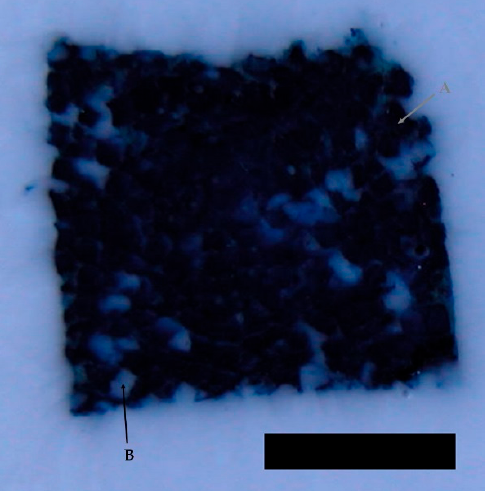
Figure 3. Illustration of pore interconnectivity in a hyaluronic acid gelatin composite scaffold. Black areas represent accessible pores whereas white areas signify secluded pores. Arrow A points to an interconnected, accessible pore. Arrow B points to a non-interconnected, secluded pore. Most of the scaffold’s area is shows a black color, thus proving excellent pore interconnectivity. Magnification bar = 1 mm.